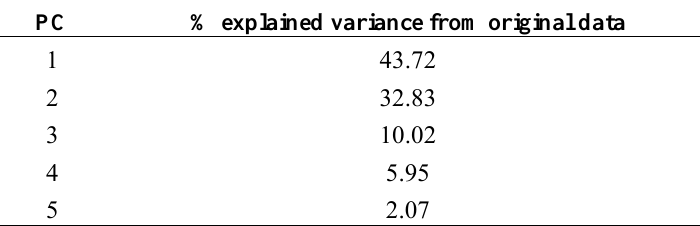
Table 3. Variance explained by